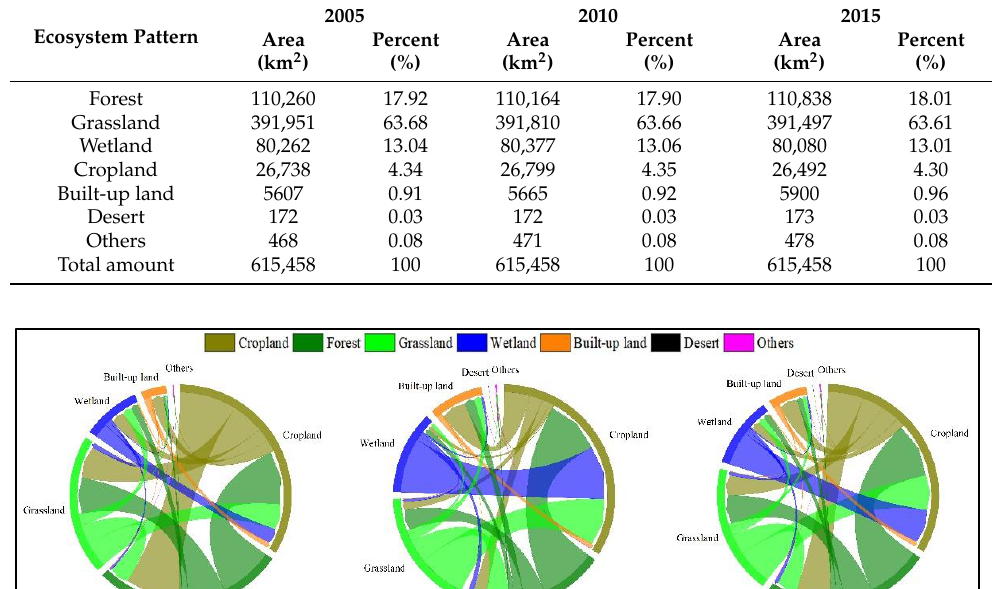
Figure 3. Spatial distribution of different land use types in the Northeast Forest Belt (NFB) from 2005 – 2015. Table 4. Statistics of different land use types of ecosystem patterns of the NFB from 2005 – 2015.